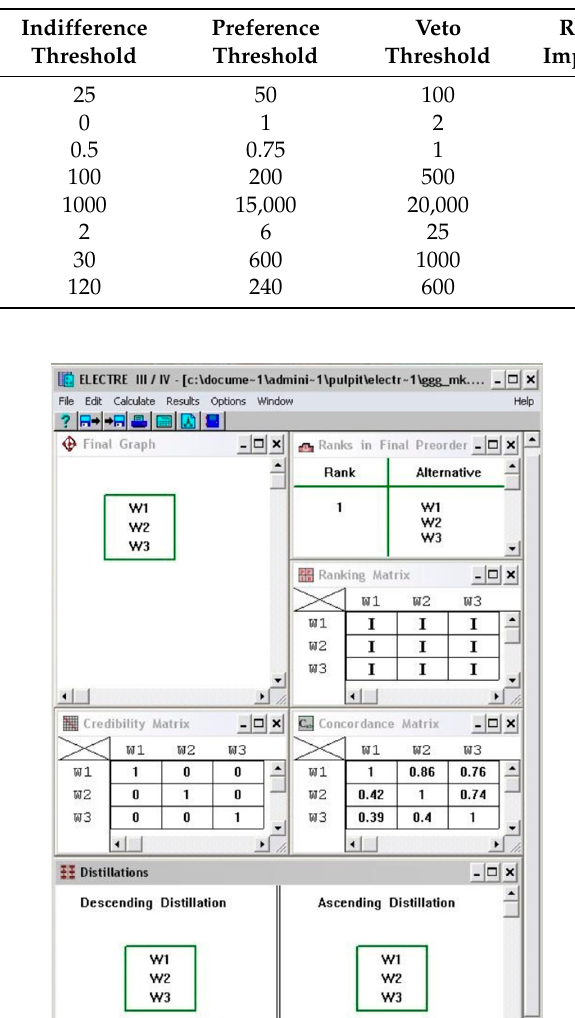
Table 4. Decision-maker’s preference model—Expert 1—Mine Manager, Chief Executive Officer.